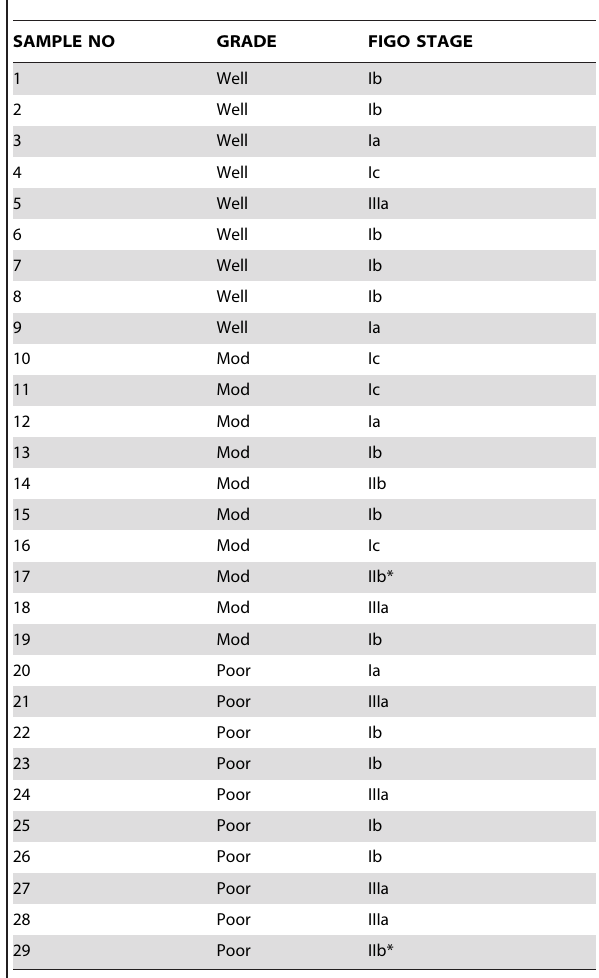
Table 1. Clinical parameters and tumour characteristics for well (n=10), moderately (Mod, n= 10) and poorly differentiated (n=10) endometrial